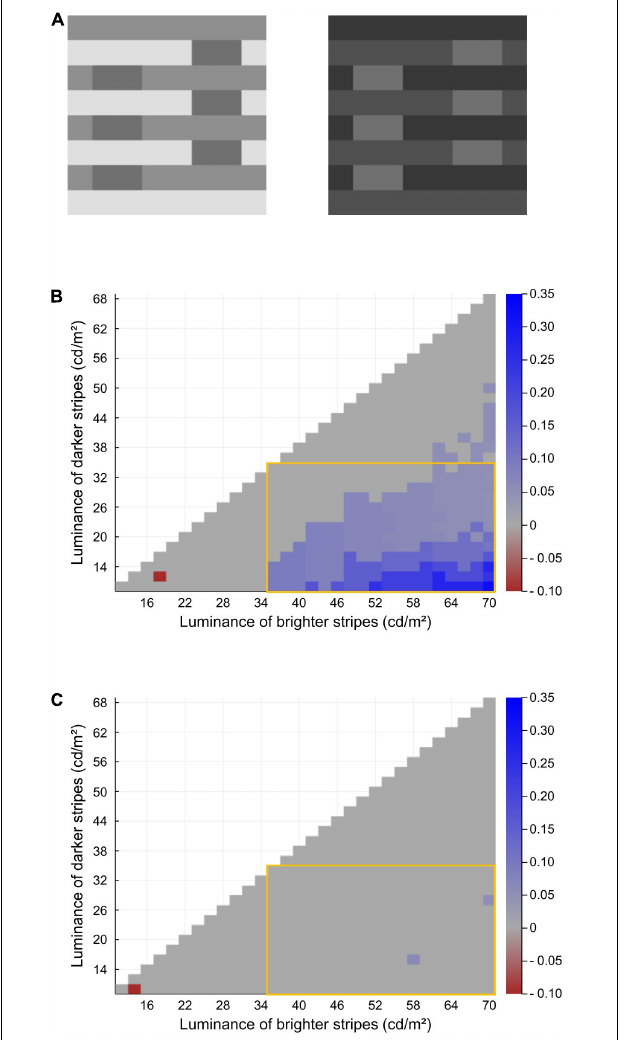
FIGURE 6 | (A) Double-increment version (left) and double-decrement (right) version of the White-effect figure. Both are considered to cause virtually no illusions. (B) Heatmap of the modified model’s illusion prediction for the White-effect figure with various stripe luminance conditions. In the original image used in Murray (2020) and the test shown in Figure 3 , the two stripes’ luminances were 17.5 and 70 cd/m 2 . (C) Heatmap of the original model’s